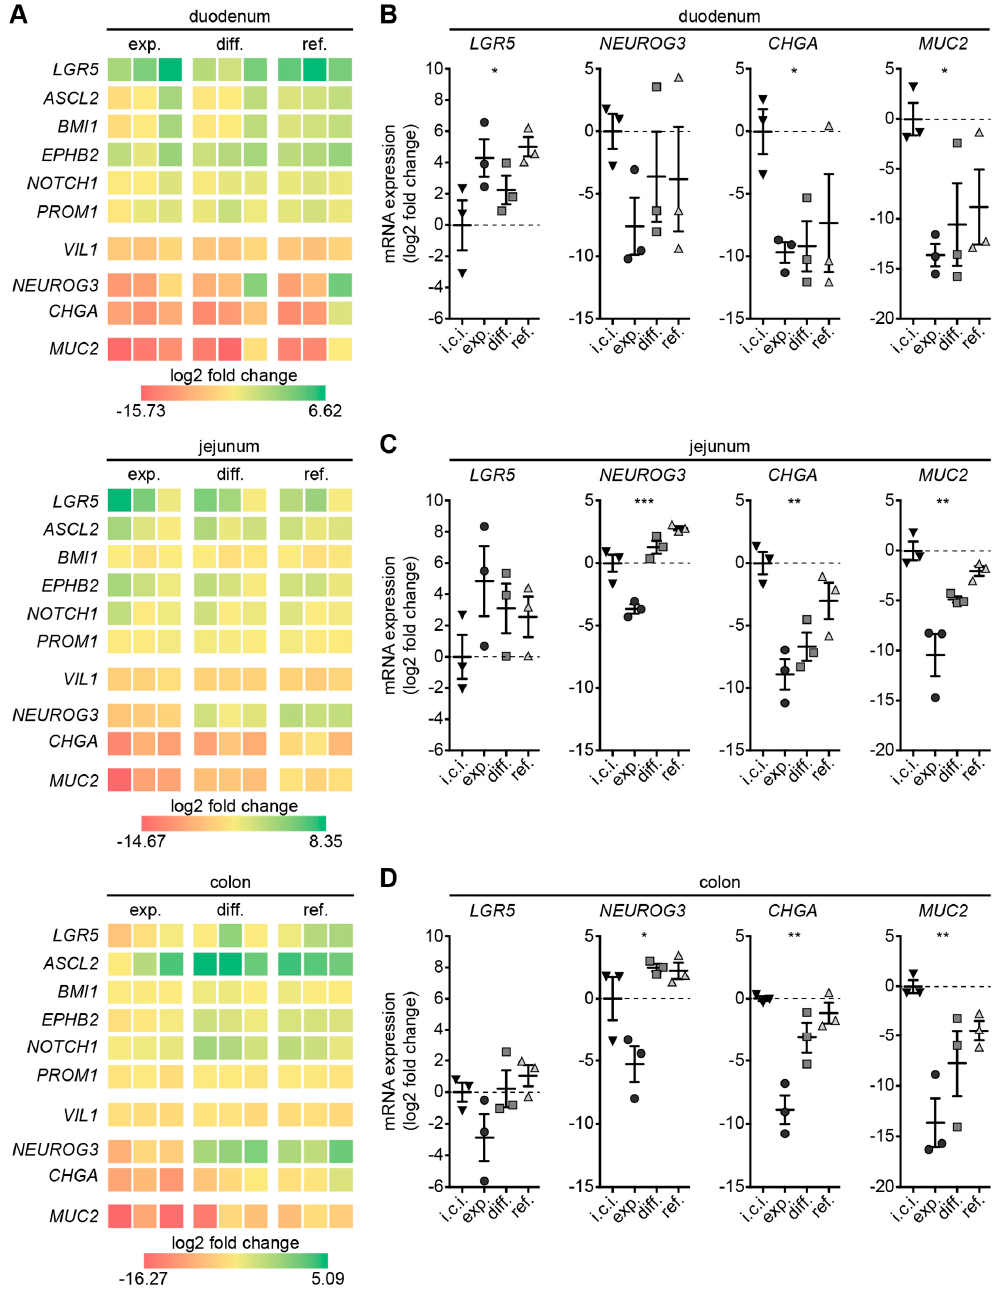
Figure 2. Refined medium and differentiation medium show elevated marker expression of enteroendocrine and goblet cells. ( A ) Heat map of log2 fold changes derived from RT-qPCR data of duodenal, jejunal and colonic organoids cultivated four days in expansion, differentiation and refined medium normalized to initial cell isolates (i.c.i. = 0); data from three individuals are shown in side-by-side columns. ( B – D ) Individual scatter dot plots of gene expression data from ( A ) shown for stem cell marker LGR5 , secretory lineage precursor marker NEUROG3 , enteroendocrine cell marker CHGA and goblet cell marker MUC2 for organoids derived from duodenum ( B ), jejunum ( C ) and colon ( D ) four days after seeding; mean is shown, whiskers are SEM; * p < 0.05, ** p < 0.01, *** p < 0.001, statistical analysis given in detail in Supplementary Table S5-S7; n = 3 dogs; i.c.i., initial cell isolates; exp., expansion medium; diff., differentiation medium; ref., refined medium.